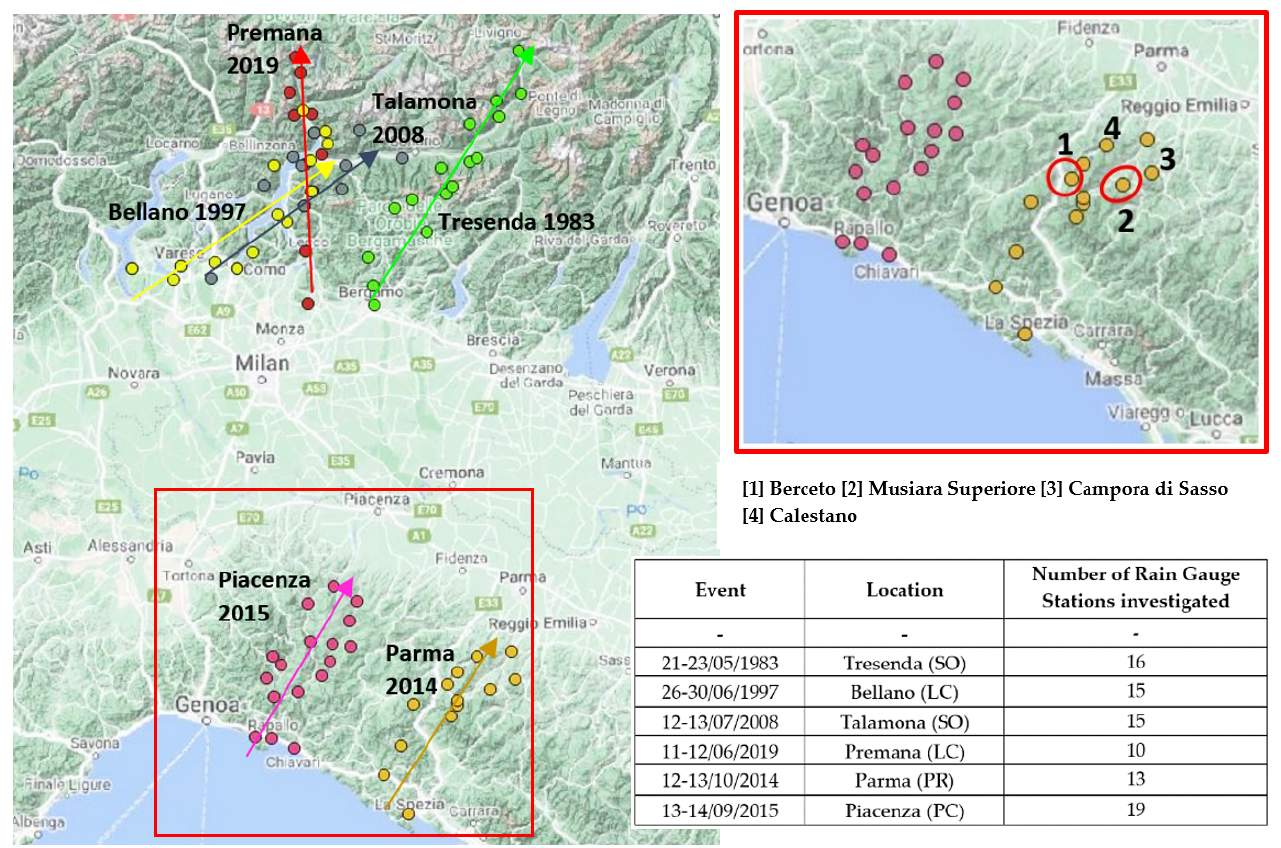
Figure 3. Rain gauge map for the area investigated of Tresenda 1983 (green), Bellano 1997 (yellow), Talamona 2008 (gray), Premana 2019 (red), Parma 2014 (orange), and Piacenza 2015 (purple). The table inset lists the number of rain gauge stations considered in this study.For the specific case of Parma 2014, two stations were discarded due to uncertainties (Berceto and Musiara Superiore) about data recorded with respect to surrounding stations while for Campora di Sasso and Calestano stations, rainfall amount were averaged comparing them with LUME results..